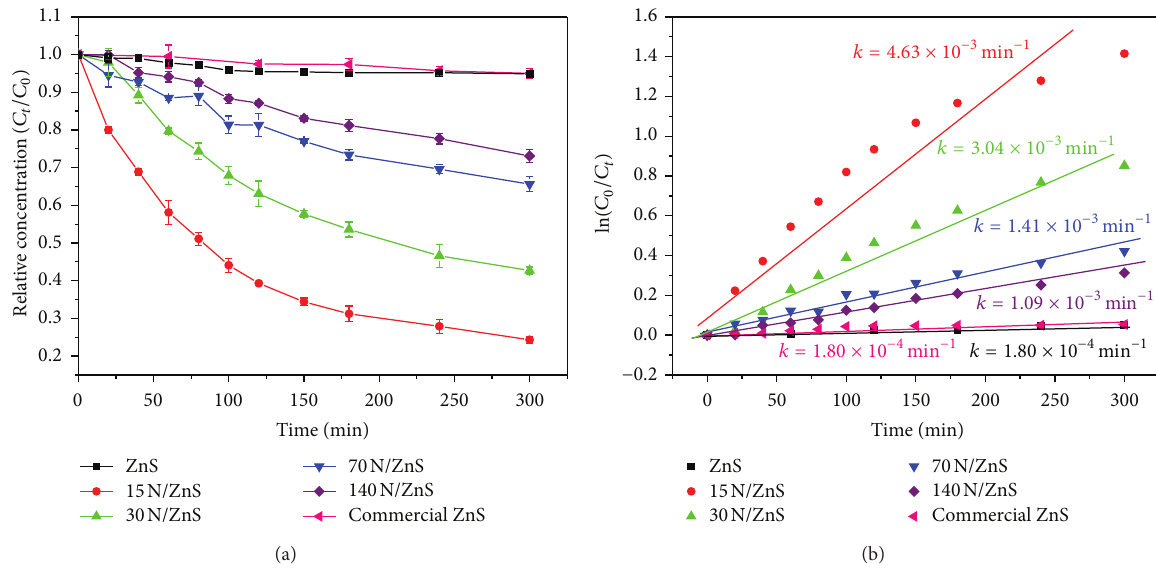
Figure 7: (a) Photocatalytic degradation of Orange II dye in the presence of bare and different nitrogen-doped ZnS photocatalysts; (b) plot of ln( 𝐶 0 /𝐶 𝑡 ) versus time for photocatalytic degradation of Orange II dye in presence of bare and different nitrogen-doped ZnS photocatalysts.